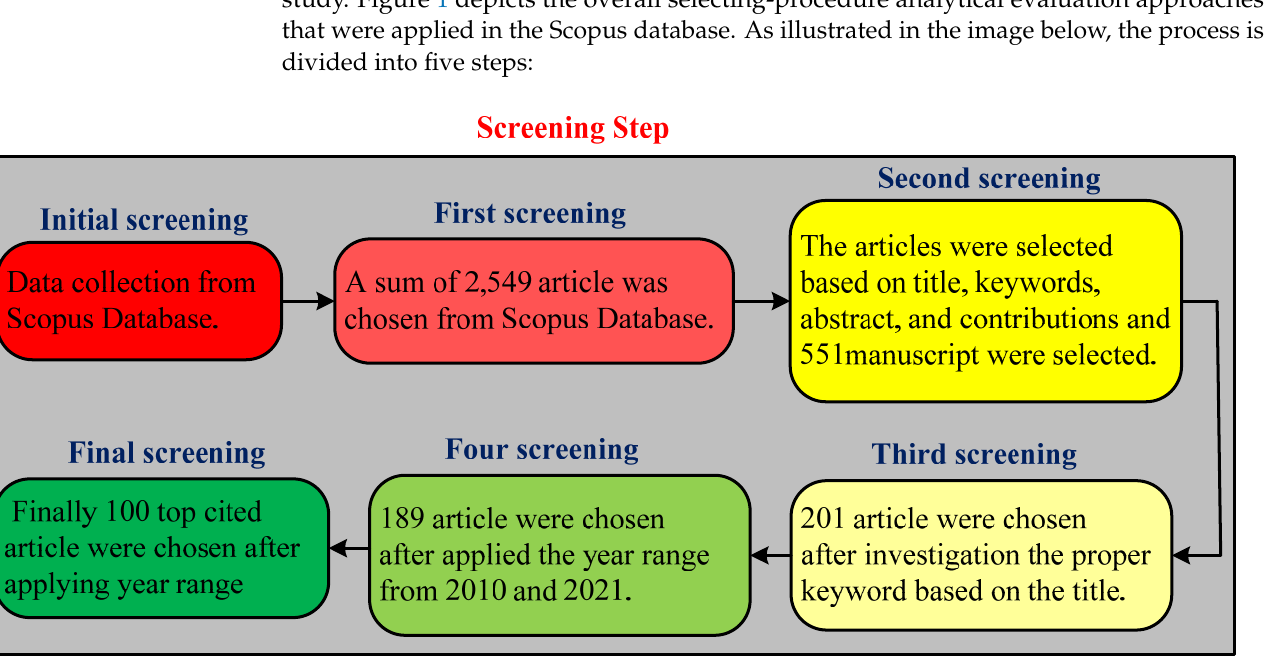
Figure 1. Block diagram of the reviewing methodology for overall article selection process.